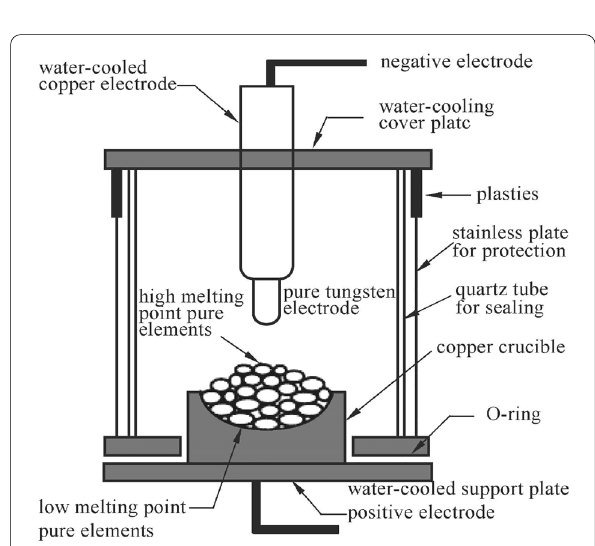
Figure 10 Schematic diagram of arc melting method